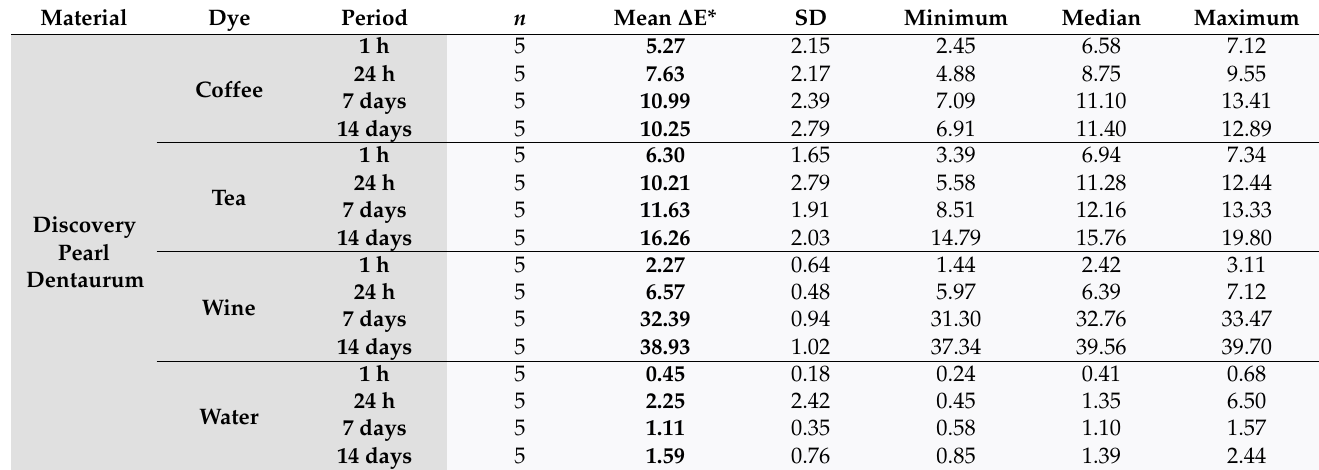
Table 6. Mean color changes of Discovery Pearl brackets with respect to incubation time and type of